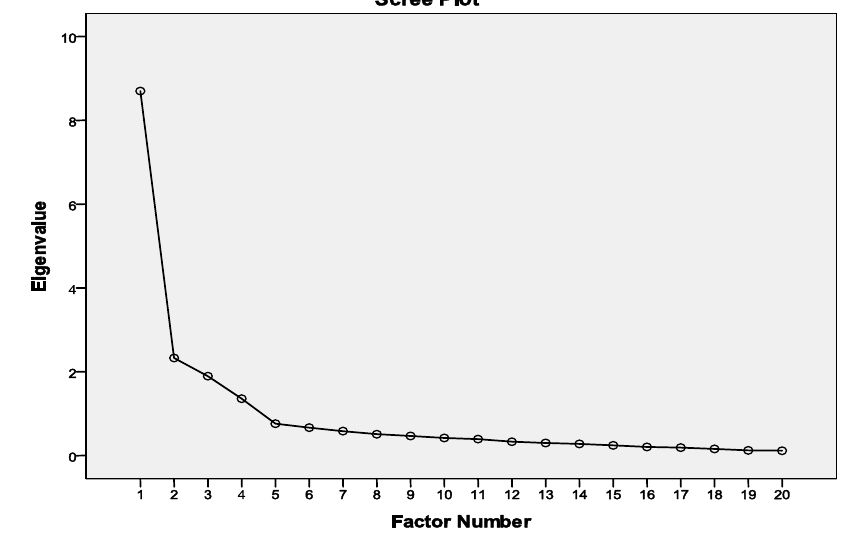
Figura 1 . Eigenvalues extraídos da análise fatorial exploratória ( Scree Plot